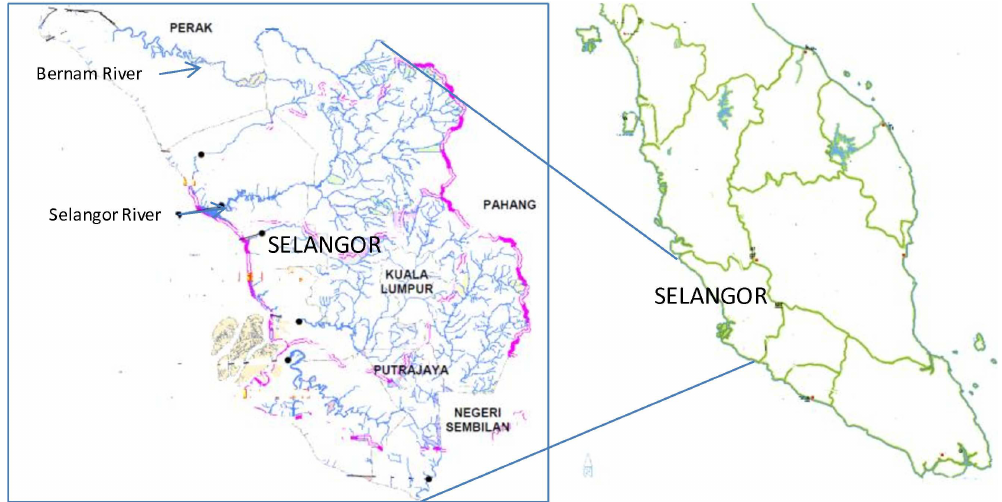
Fig. 5. Location of the study sites.